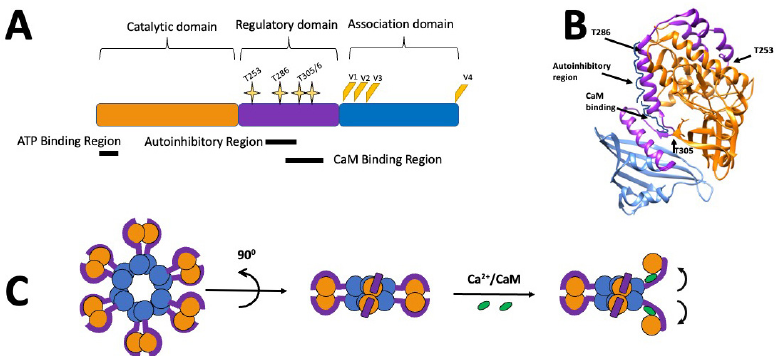
Figure 1. Schematic representations of the molecular structure of CaMKII α : ( A ) CaMKII consists of a catalytic domain (orange), a regulatory domain (purple), which includes overlapping autoinhibitory and calmodulin (CaM) binding regions and multiple phosphorylation sites (yellow stars). The association domain (blue) is involved in the formation of CaMKII multimers. Splice sites (V1–4) are represented in orange/yellow. ( B ) Crystal structure (3SOa) of a single CaMKII α subunit created using Chimera [44]. ( C ) Representation of the CaMKII α holoenzyme structure, with the domains shown in the same colours as in ( A ), and showing the movement of the subunit and its catalytic domain following activation with